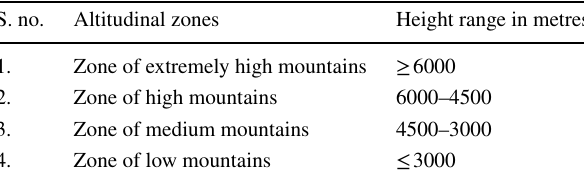
Table 3 Altitudinal zones: Gangotri glacier valley, Garhwal Himalaya S. no.